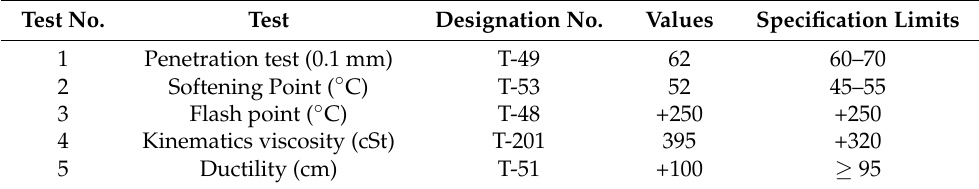
Table 2. Physical properties of asphalt binder. Test